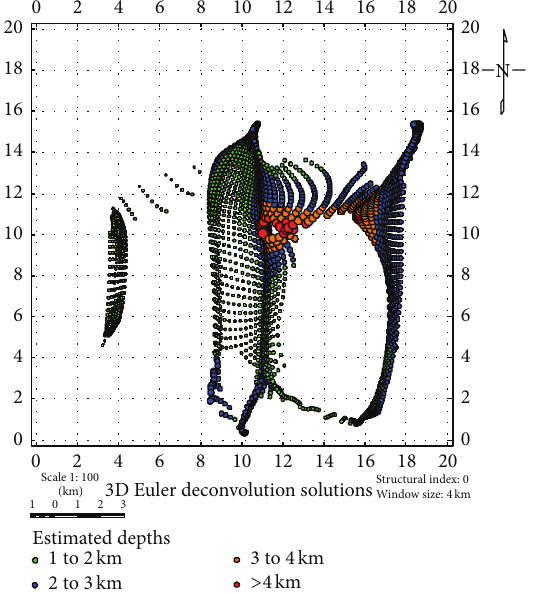
Figure 7: Distribution with depth of gravity anomaly sources estimated by the 3DED